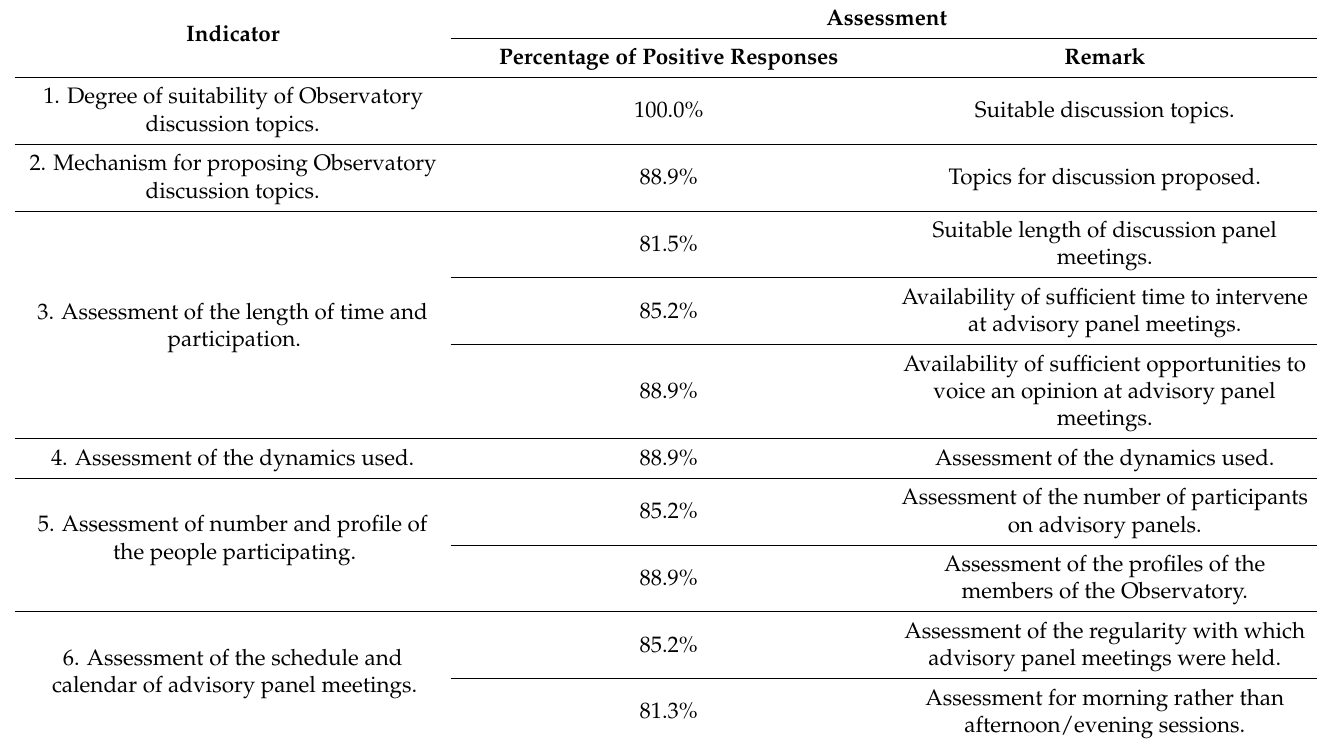
Table 4. Evaluation of the dynamics and organisation of the Water